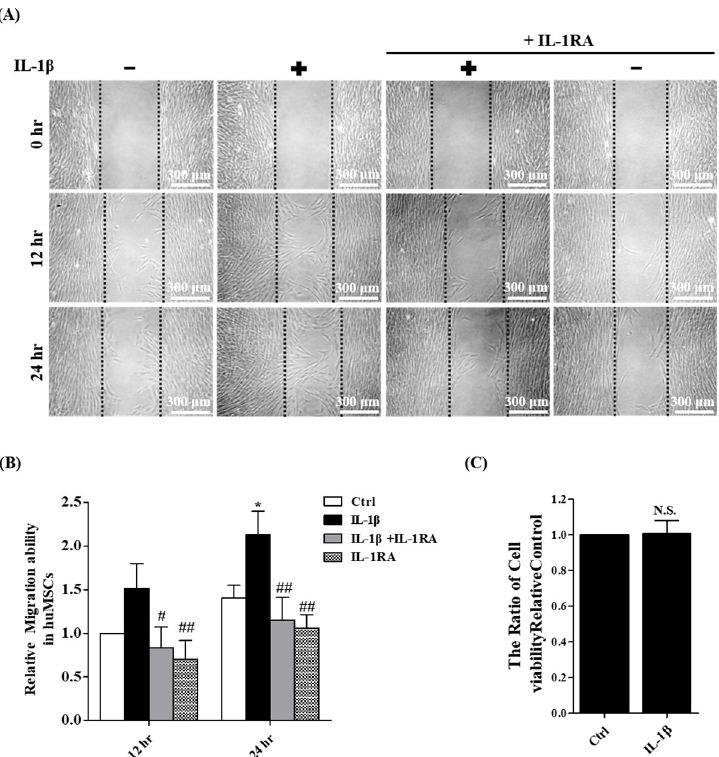
Fig 1. IL-1 β stimulates mesenchymal stem cell migration. (A) Cell wound healing assay for IL-1 β stimulated mesenchymal stem cells in the presence or absence of 2 μ g/ml IL-1RA (IL-1 β inhibitor) at 12 and 24 hours. Scale bars = 300 μ m. (B) The wound area of hUCMSCs were indicated by MetaMorph and the data were normalized with control and shown as the mean ± SD (n = 3, � P < 0.05, �� P < 0.01 versus control cells, #p < 0.05, ##p < 0.01 versus IL-1 β treated cells). (C) Cell viability assay for IL-1 β stimulation. Data were quantified by multimode micro-plate readers. Data are shown as the mean ± SD (n = 3) (N.S.: nonsignificance).